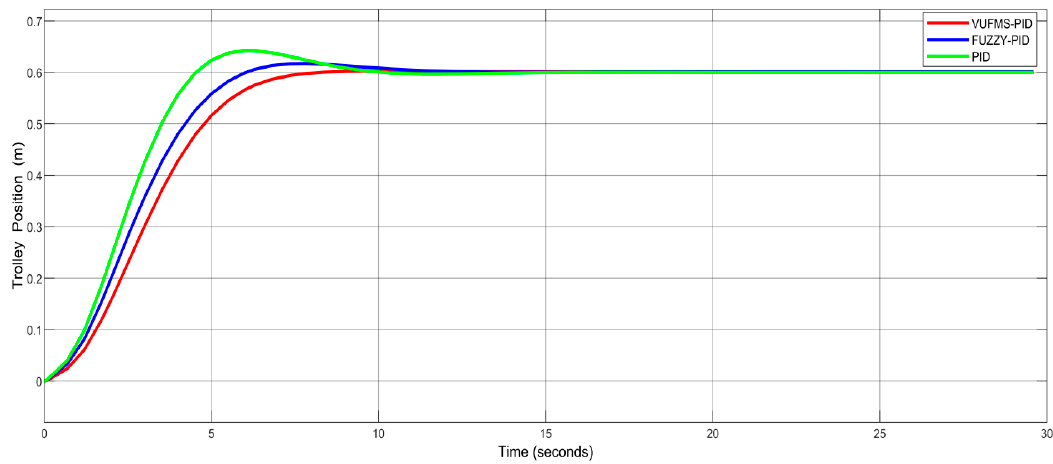
Figure 6. Trolley’s position (x) using VUFMS-PID, FUZZY-PID and PID controller.